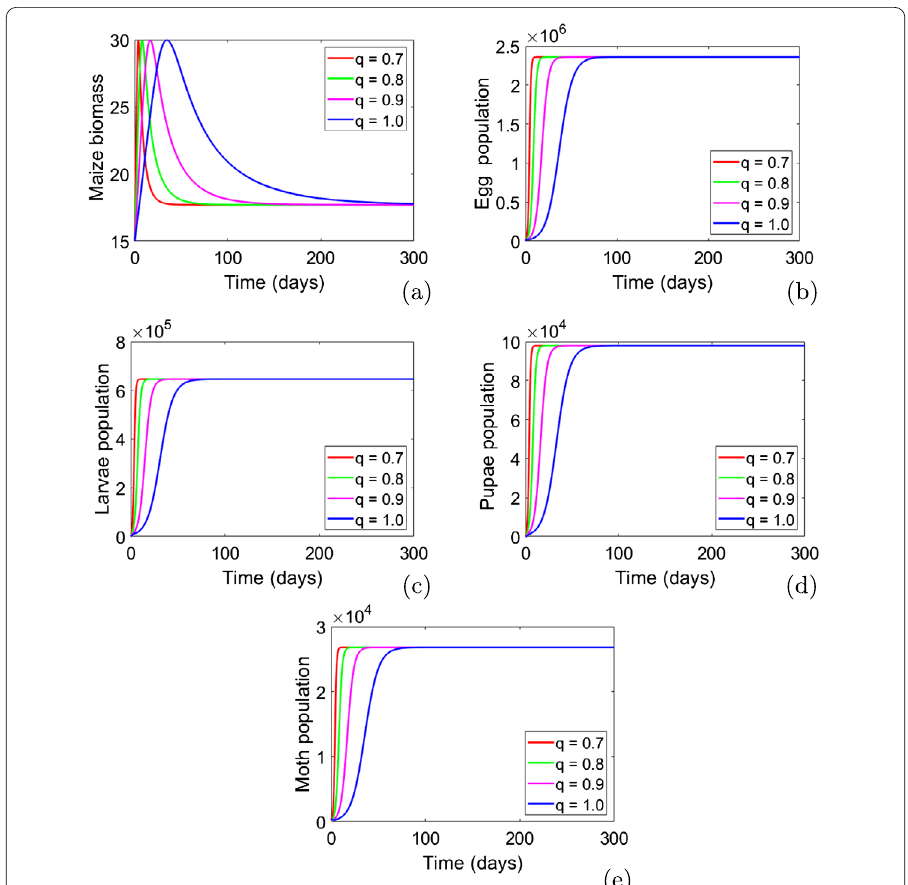
Figure 5 Numerical results of system (1) demonstrating the convergence of solutions to the pest persistence equilibrium point for R 0 > 1. Baseline values for the model parameters are as in Table 2. In addition, we set u E = u L = u P = u A = 0.35 to obtain R 0 = 2.8931. As we can observe, the solutions suggest that the pest will persist in the field and the final maize biomass will be less than the expected 50 kg plant